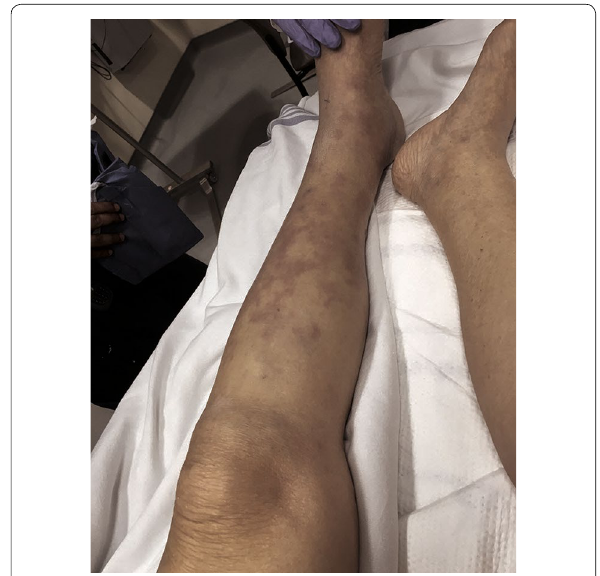
Fig. 1 Left lower extremity upon presentation to the emergency department. Note mottling of skin but no